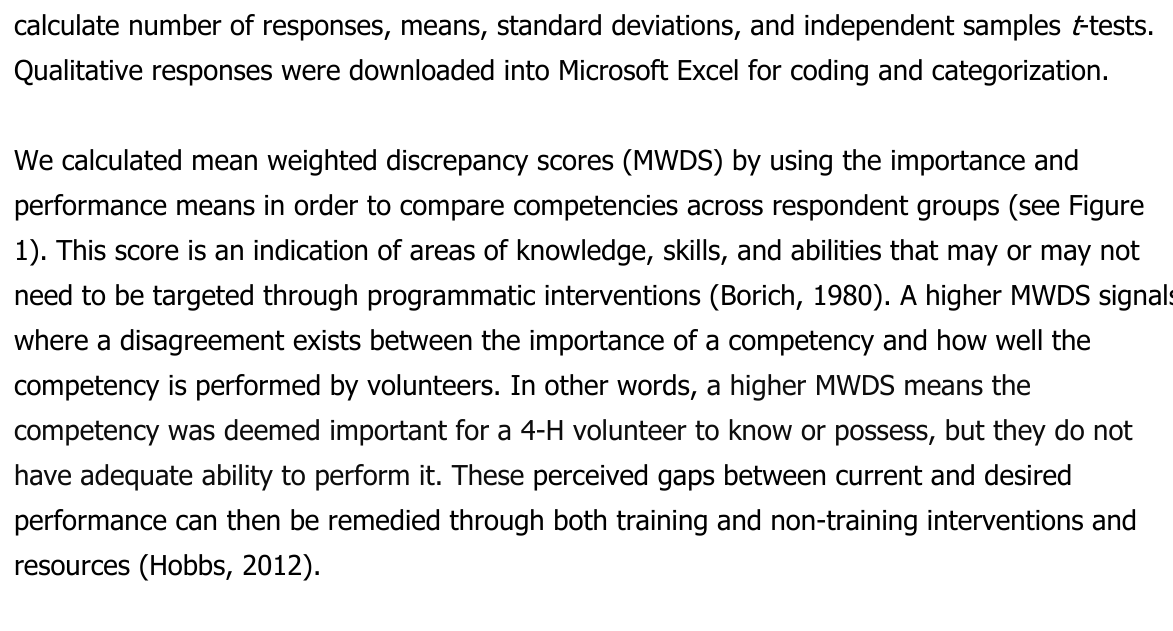
Figure 1. Steps to Calculating Mean Weighted Discrepancy Scores: The Borich Model Step 1: (Importance mean - Performance mean) = Performance Discrepancy Score Step 2: Performance Discrepancy Score × Importance mean = Mean Weighted Discrepancy Score